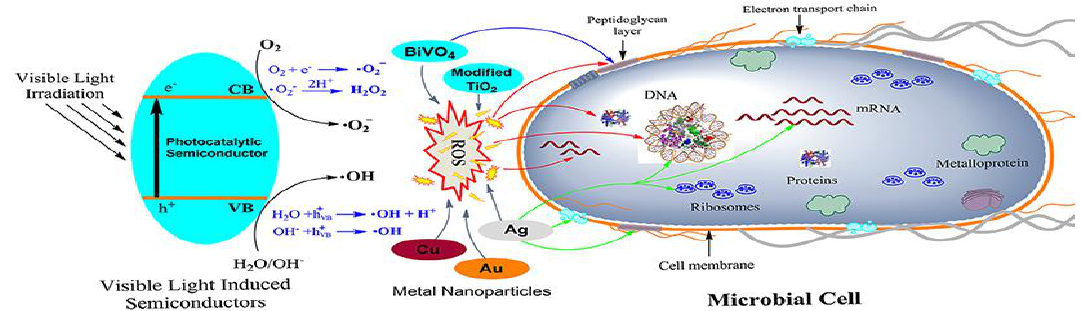
Figure 6. Schematic representation of the antimicrobial mechanisms proposed for different photocatalytic semiconductors. As shown on the left side, the photocatalytic semiconductor is activated via visible light. The main targets of ROSs generated by the semiconductors are indicated with red colored arrows, while the blue and green colored arrows indicate the target of BiVO 4 and Ag nanoparticles, respectively. Reproduced from [55].